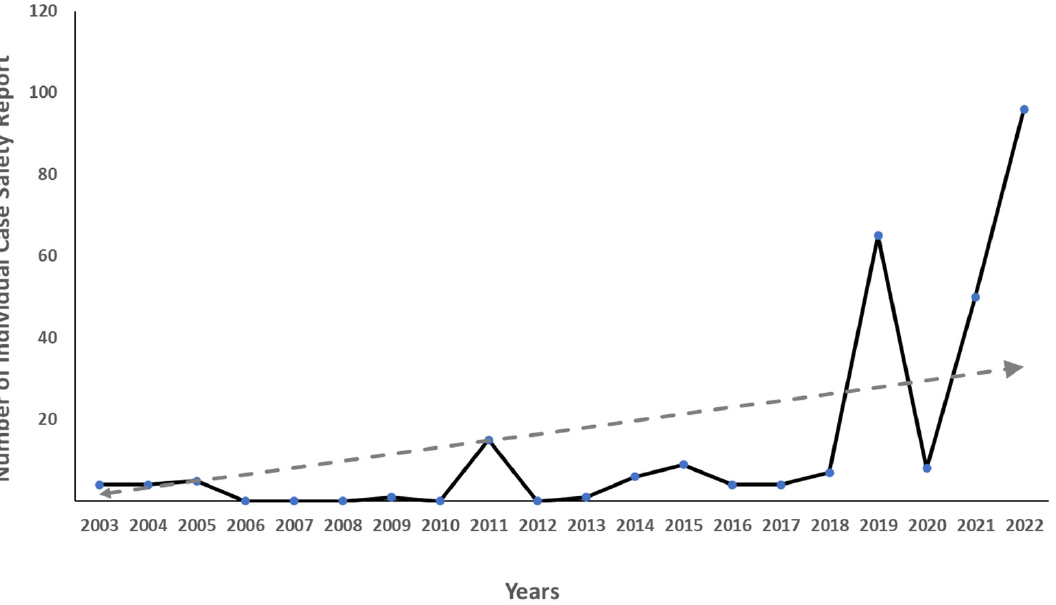
Figure 1. Trends in the number of Individual Case Safety Reports (ICSRs) in Jordan between 2003 and